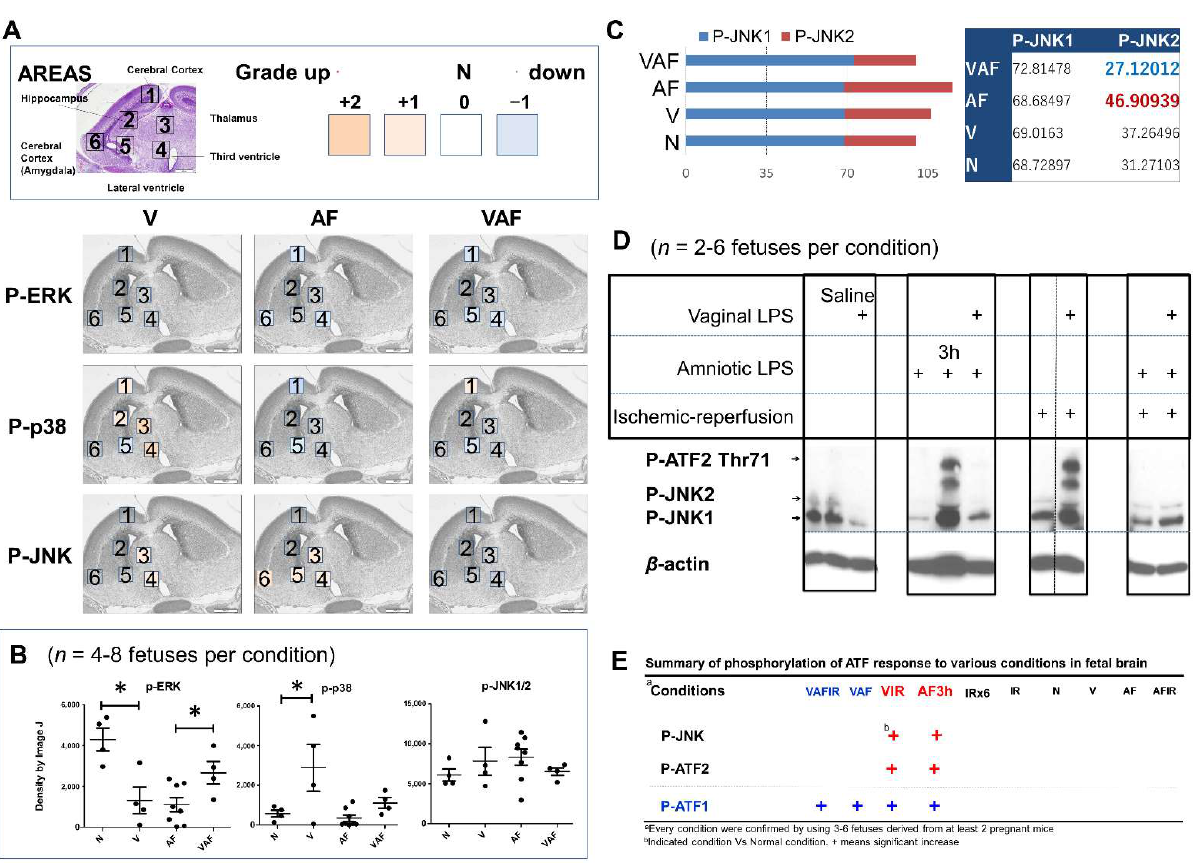
Figure 4. The phosphorylation of mitogen-activated protein kinase pathways and transcription factors. ( A ) Three fetuses derived from three pregnant mice per group were used for immunochemical staining. Each fetal brain was separated into six fields (1–6). The grades (0–4) of phosphorylated protein in the paraffin-embedded sections areas, which we indicated using different colors. ( B ) Western blot data of phosphorylated ERK1/2, P38, and JNK1/2. * p < 0.05. ( C ) The average percentage of phosphorylation of JNK1 and JNK2, normal condition (N) is 100%. ( D ) Phosphorylated ATF2 and JNK in the whole fetal brain under indicated conditions. ( E ) Summary of western blot data: strong phosphorylation (++) of both JNK and ATF conditions were indicated.